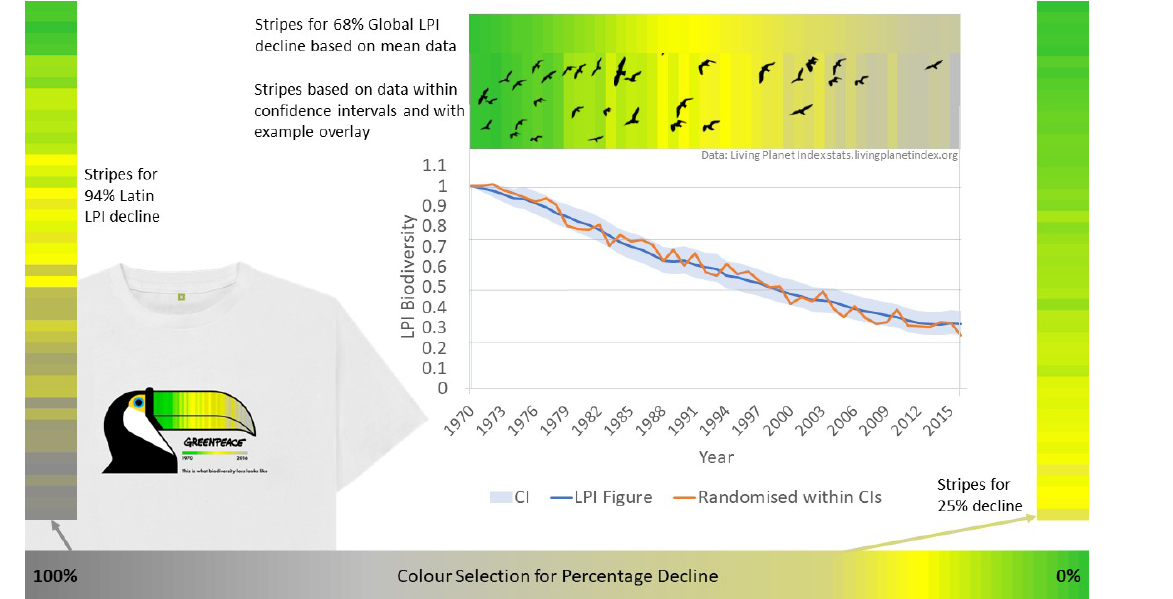
Figure 1. LPI mean and “striped” data in traditional line-chart form and represented with stripes, together with overlay, colour-selection map examples, and use on a Greenpeace T-shirt (©